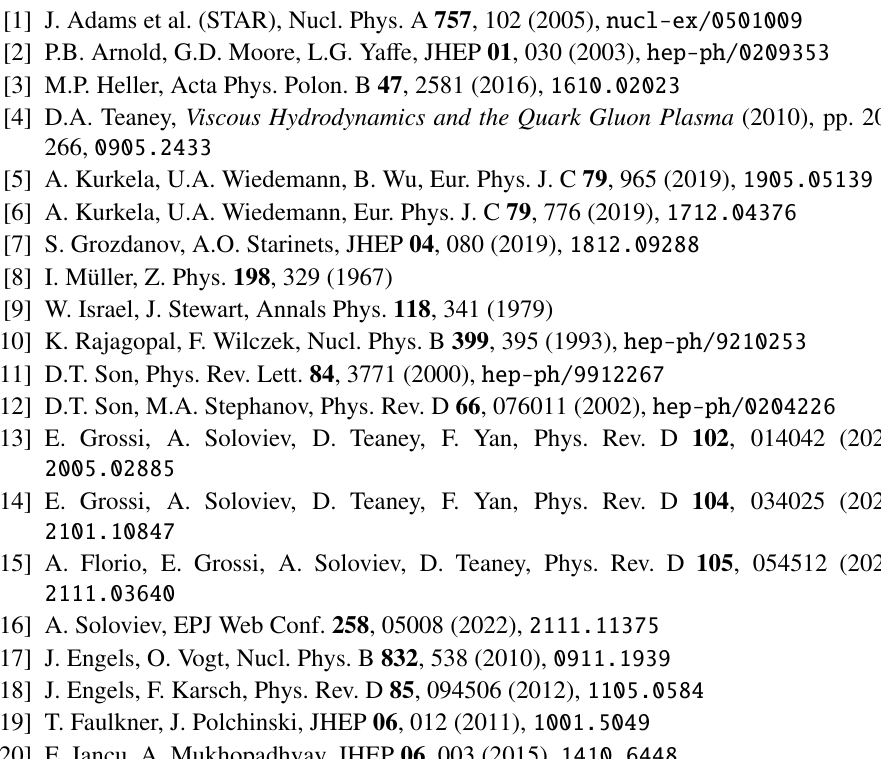
Another important direction is to see the interplay of QNM poles with branch cuts typical to kinetic theory, especially in the vicinity of a phase